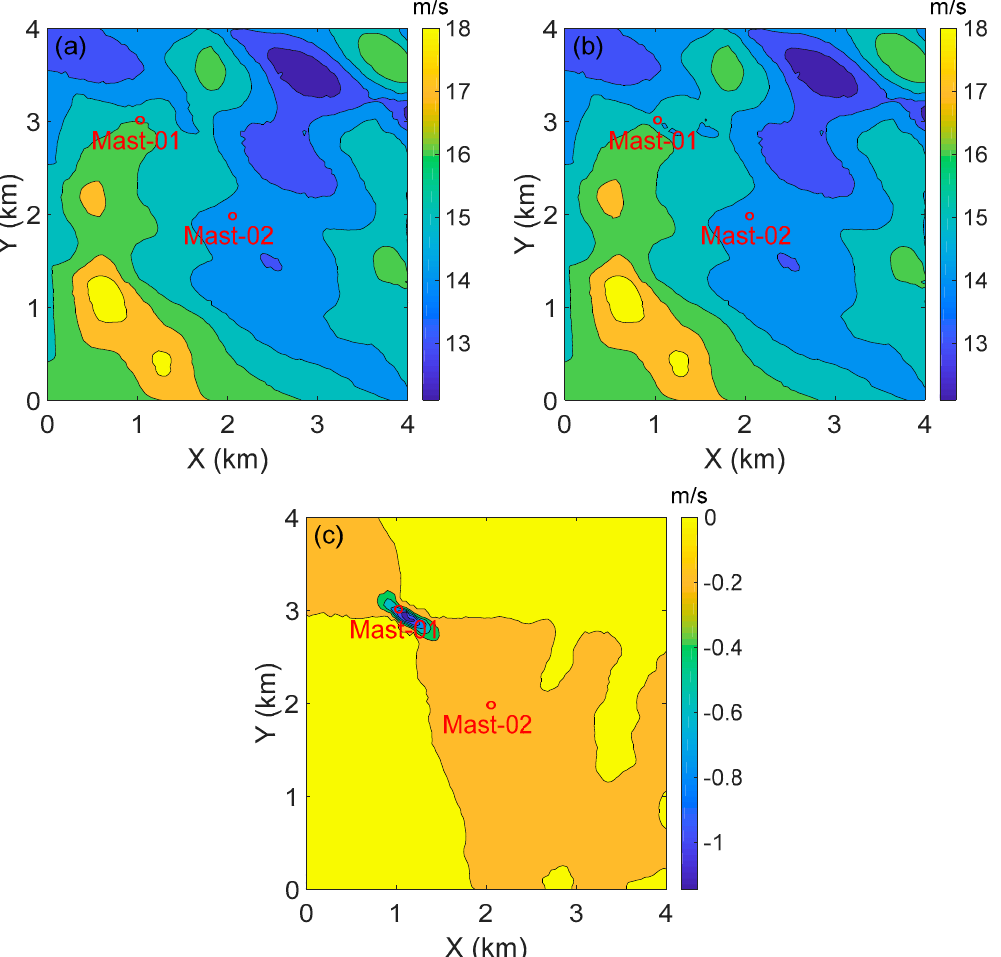
Figure 14. The u velocity component cross-section at 400 m altitude: ( a ) CFD model simulation without assimilation; ( b ) CFD model simulation with assimilation; ( c ) difference between the CFD model simulation with and without assimilation.